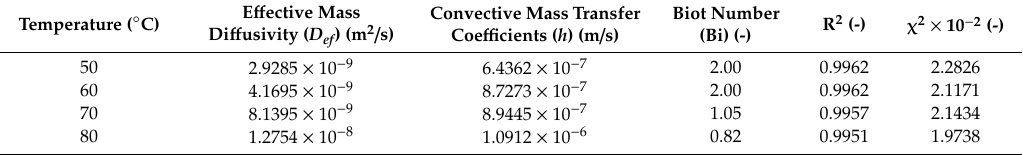
Table 3. E ff ective mass di ff usivity, convective mass transfer coe ffi cient and Biot number for model 1. E ff ective Mass Temperature ( ◦ C) Di ff usivity ( D ef ) (m 2 / s) Table 3. Effective mass diffusivity, convective mass transfer coefficient and Biot number for model 1.